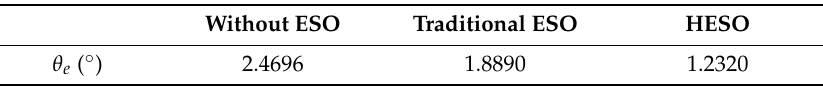
Table 2. Comparison of control performance in the tracking error of pitch angle with different ESO (RMS